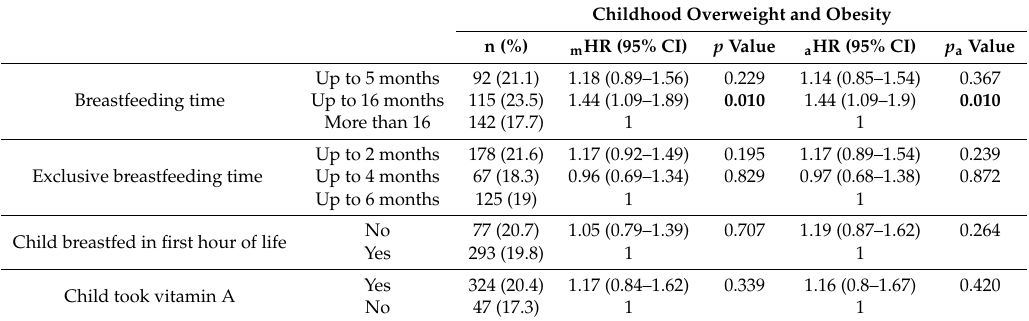
Table 5. Nutritional factors associated with overweight / obesity in children aged 2–6 years, Cear á , 2017. Childhood Overweight and